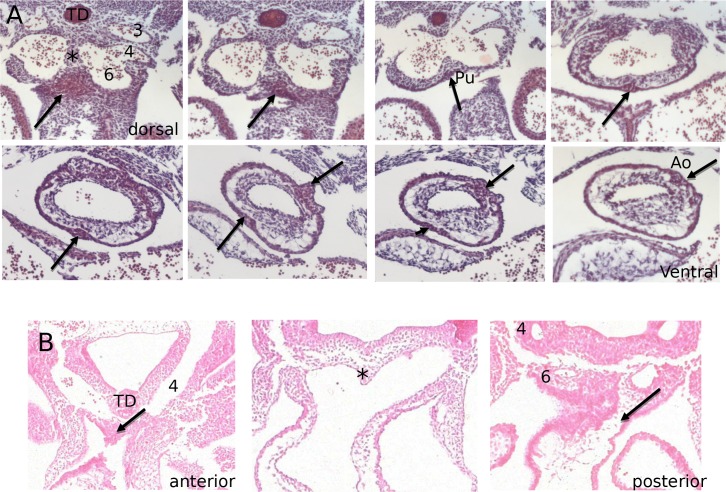
Histological appearance of the IC as they first form.(A) Frontal serial sections through the pharyngeal arch arteries show the first appearances of the cellular condensations that form the aortic and pulmonary ICVS (arrows). The most dorsal and ventral images are indicated. (B) Transverse sections through the pharyngeal arches and distal outflow tract also show the first appearances of the ICVS (arrows). In this case the most anterior and posterior sections are labeled. For reference, in both sectional planes the thymus diverticulum (TD) and the wall that separates the left from right arch arteries (*) are indicated. 4/6 = 4th/6th pharyngeal arch artery, Ao = aortic ICVS, Pu = pulmonary ICVS.